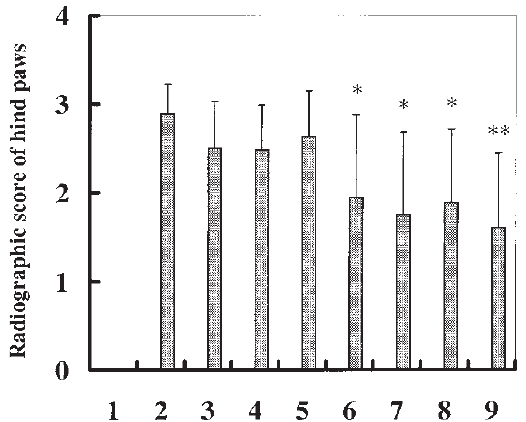
FIGURE 2 The effect of E. faecium (EF) selenium (SSe), methotrexate (MTX) and their combinations on radiographic scores in rats assessed on day 50. Designation of rat groups as in Fig. 1. Data represent mean values ^ SD for 10 rats. Significantly different from arthritic control rats: * p , 0 : 05 ; ** p , 0 : 01